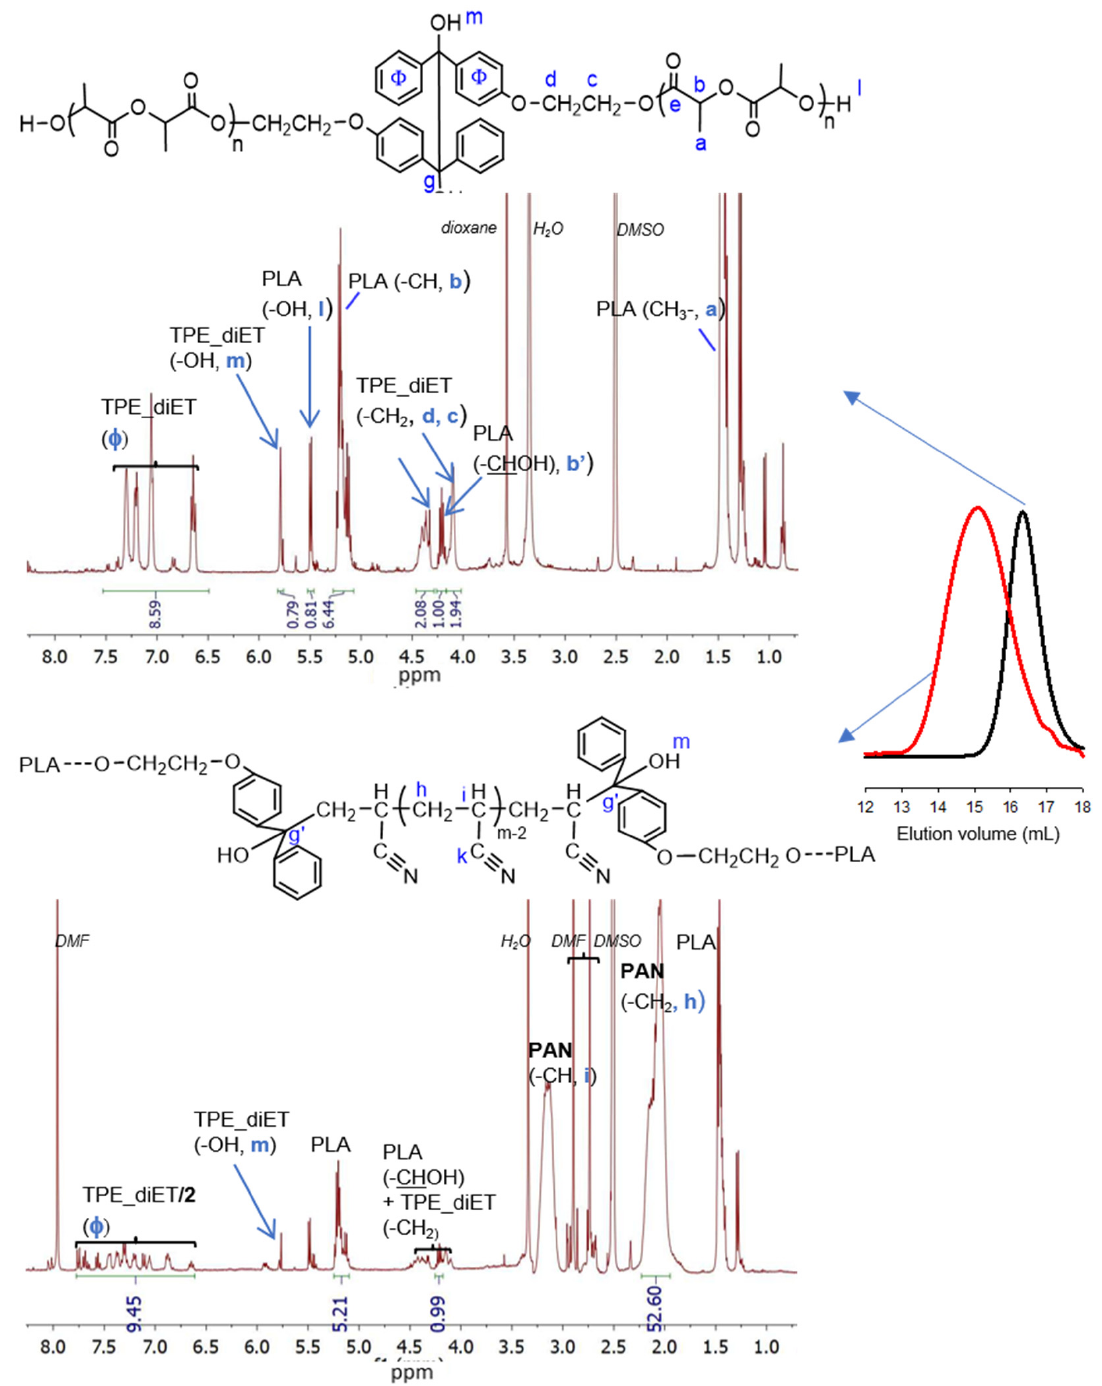
Figure 4. 1 H NMR spectra (DMSO-d6) and SEC curves (DMF) of TPE-diET_PLA, M n = 1400 (on the top, SEC black line), and the precipitated product of the AN polymerization initiated with TPE-diET_PLA; m AN /m PLA in feed =1; 24 h (on the bottom, SEC red line). In the 1 H NMR spectrum, all the signals that were expected for the